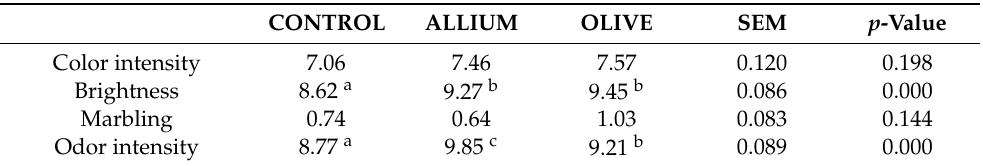
Table 5. Means of the sensory attributes analyzed in fresh pork loin of pigs fed with different treatments (0–10 cm scale).